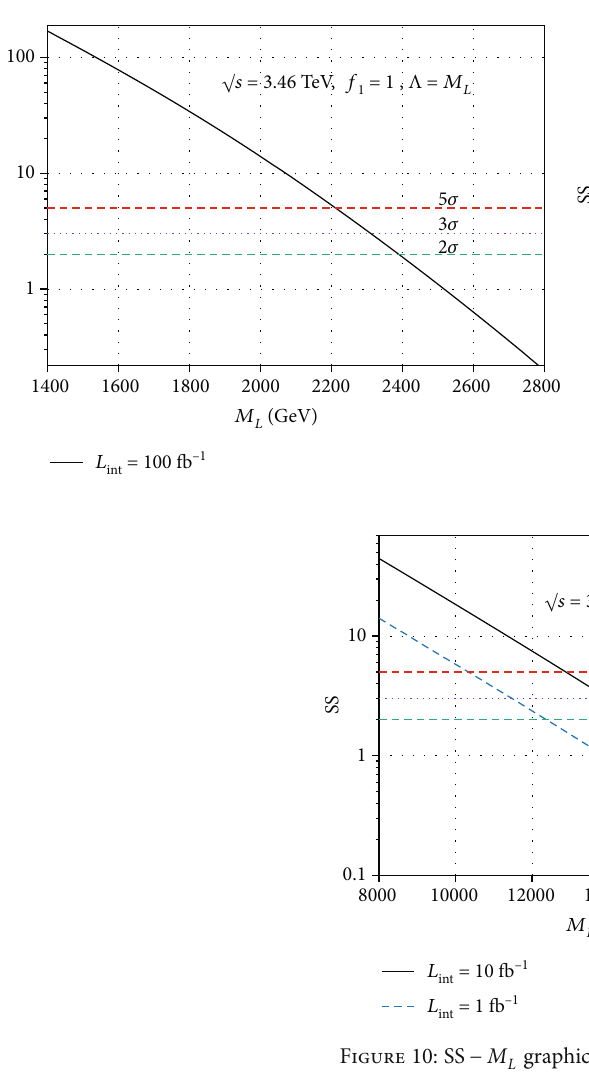
graphics for I L